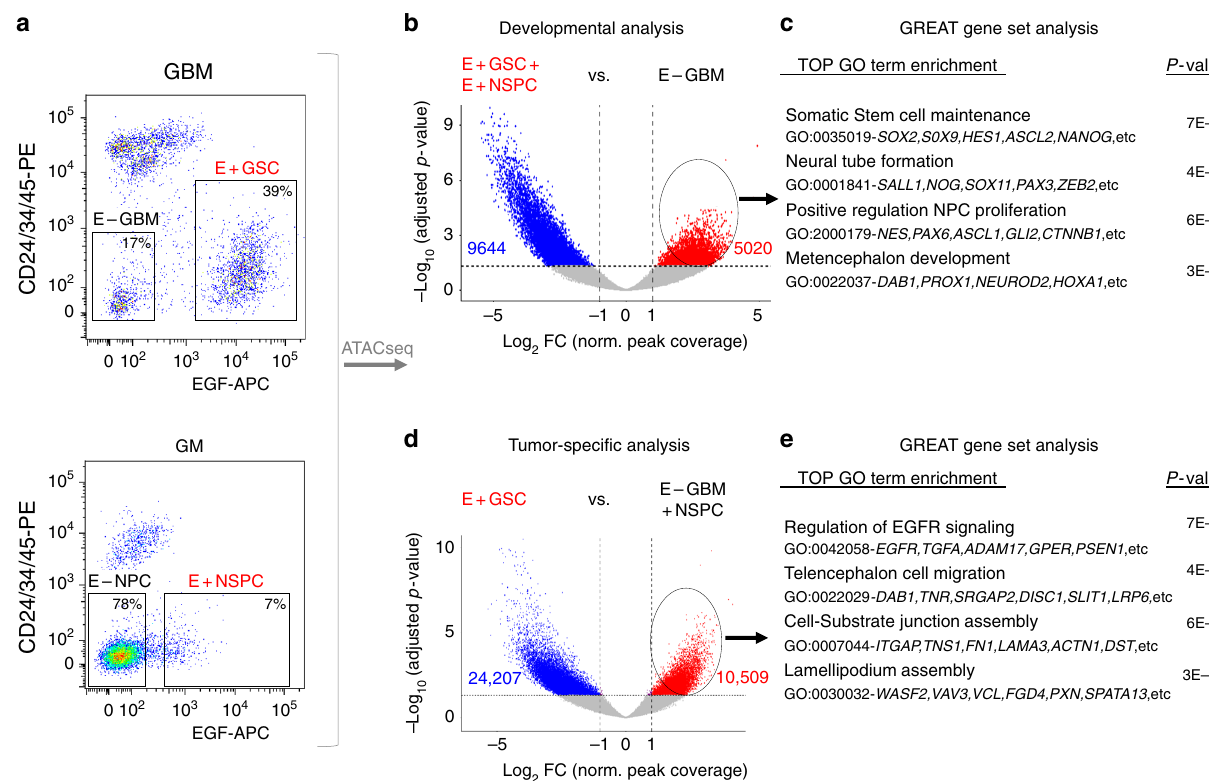
Fig. 1 Chromatin accessibility analysis in acutely isolated human GSCs and NSPCs. a FACS plot showing isolation strategy of GBM and neural germinal matrix (GM) populations used for ATAC-seq preparation. See also Supplementary Fig. 1. b Differential ATAC-seq peak analysis between the union of E + GSC and E + NSPCs ( n = 7) and E – GBM ( n = 3) de fi nes 5020 signi fi cantly enriched, developmentally shared peaks in E + GSCs. c Functional enrichment analysis of developmentally shared E + GSC peaks using GREAT. Illustrated are top signi fi cantly enriched gene ontology (GO) terms and examples of the corresponding annotated genes, which relate to stem-cell maintenance and proliferation. d Differential ATAC-seq peak analysis between E + GSC ( n = 4) and the union of E – GBM and NSPCs ( n = 9) de fi nes 10,509 signi fi cantly enriched peaks unique to tumor E + GSCs. e Functional enrichment analysis of GSC tumor-speci fi c peaks using GREAT. Illustrated are top signi fi cantly enriched GO terms and examples of the corresponding annotated genes, which relate cell migration, cell-substrate assembly, and EGFR